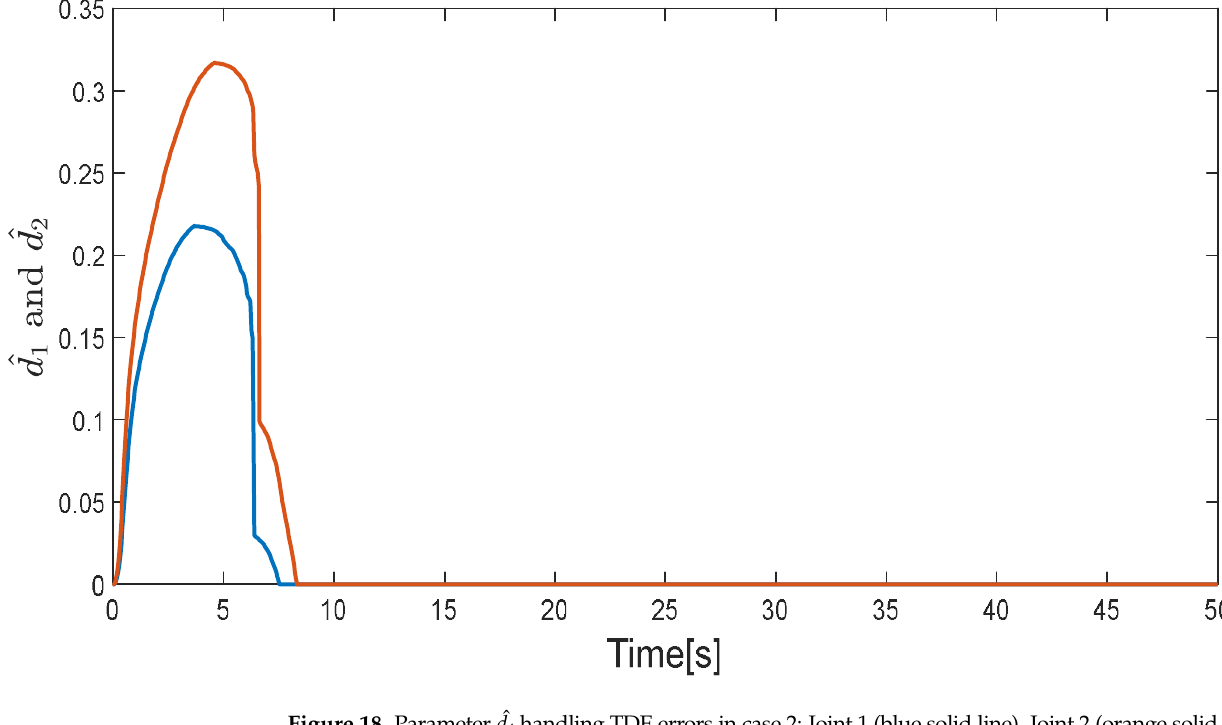
Figure 18. Parameter ˆ d i handling TDE errors in case 2: Joint 1 (blue solid line). Joint 2 (orange solid line).